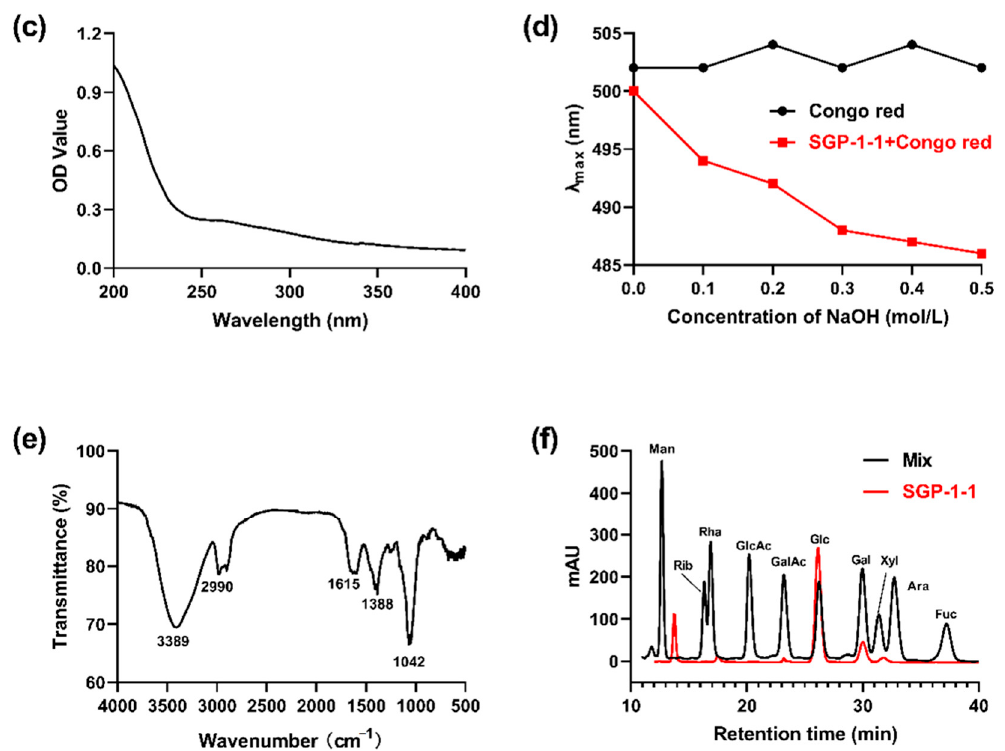
Figure 1. ( a ) Chromatography by DEAE Sepharose Fast Flow; ( b ) Sephadex G 100 separation; ( c ) UV spectra; ( d ) triple-helix-structure analysis; ( e ) FT-IR spectrum; ( f ) monosaccharide-composition analysis of SGP-1-1.